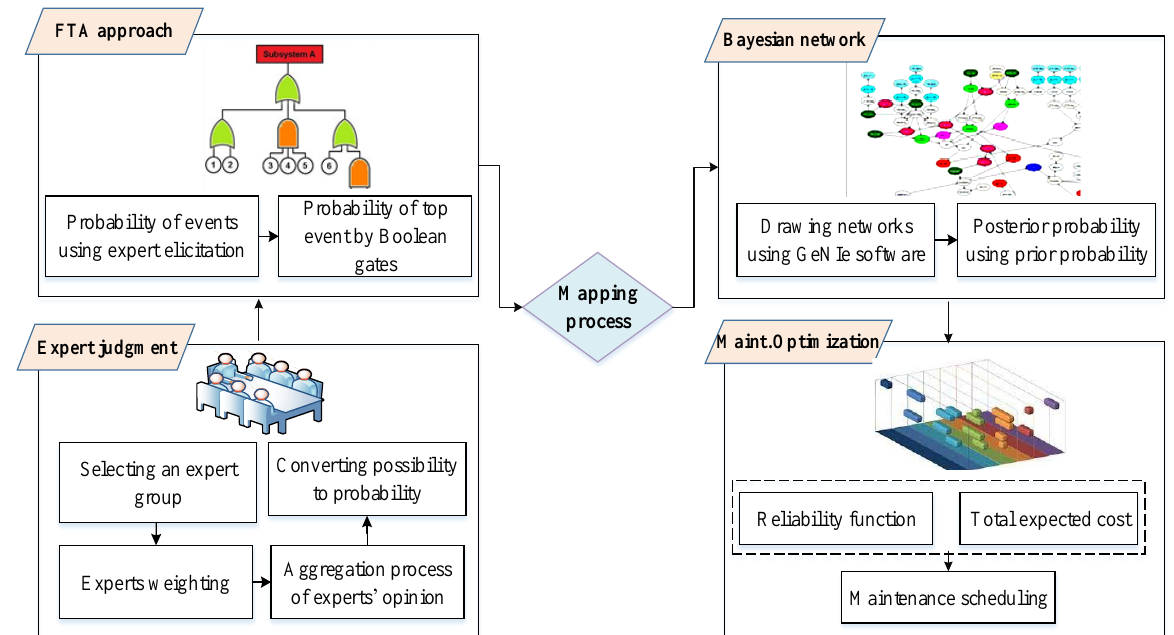
Figure 2. The proposed framework of the FFTA – BN structure-based maintenance optimization.